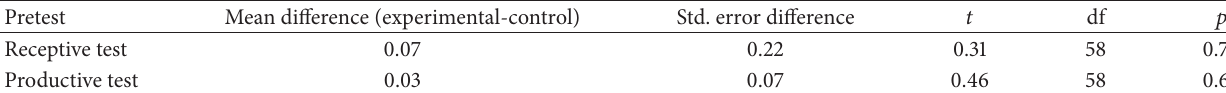
Table 6: Independent samples t -tests for the receptive and productive pretests.